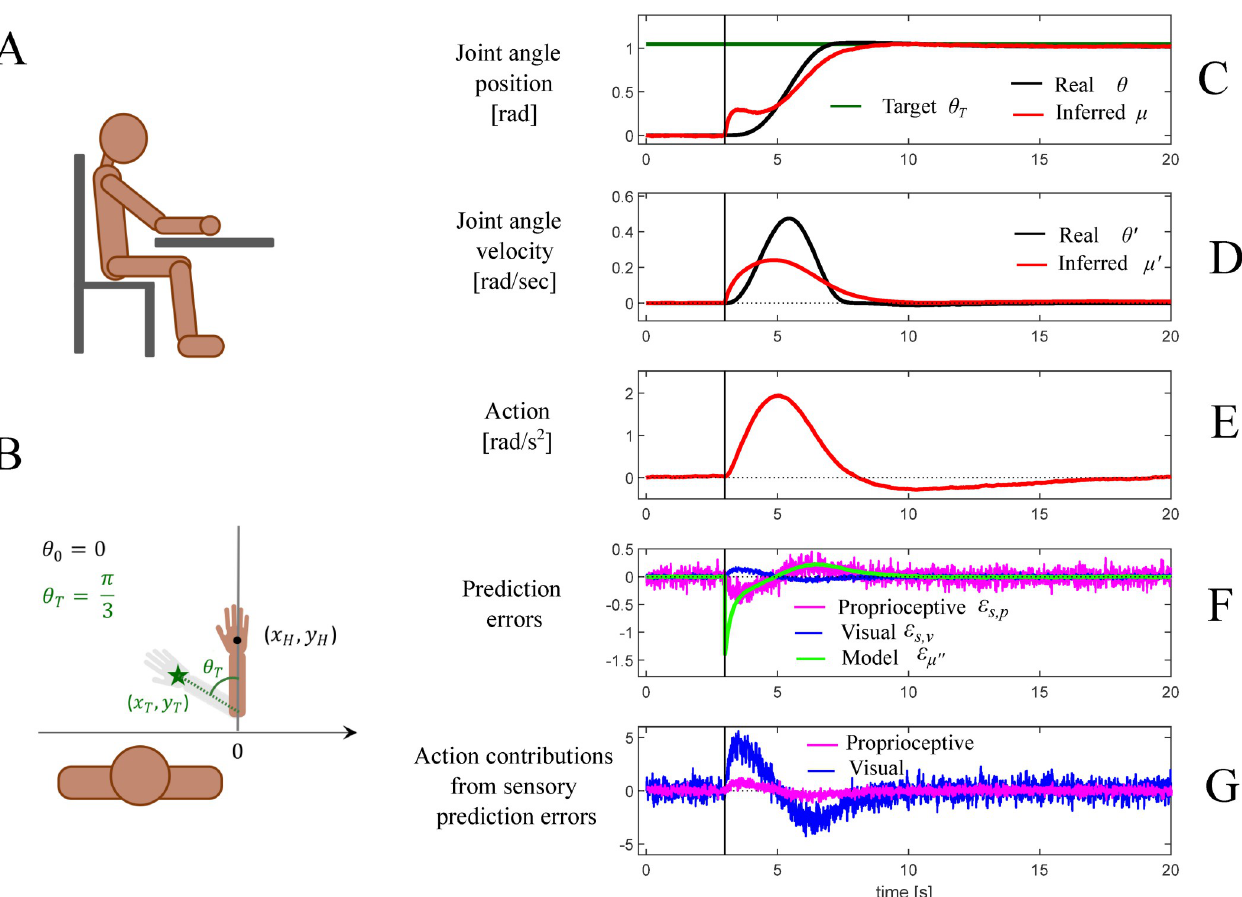
Fig 7. First simulation: reaching a fixed target in space. (A) Schematic representation of the agent having direct vision of his own arm, which initially rests on a table surface and could only move by rotating the elbow around the vertical axis. (B) Task specification. The agent has to reach a target location (green star) by rotating the arm so to reach the configuration shown in grey, at θ , corresponding to having the hand at the target location [ x ] = g(θ . (C-G) T T , y T T ) Dynamics of the model variables during the task. The vertical bars mark the time at which the target location is disclosed. (C) Joint angle of the real (black) and inferred (red) arm configurations, expressed in radians; the green line represents the arm configuration θ for which the hand is on the target. (D) Real T (black) and inferred (red) velocity of the elbow joint angle velocity. (E) Action, represented in our model as an angular acceleration. (F) The three prediction errors considered in the model: model dynamics error (green) and the two sensory errors, proprioceptive (magenta) and visual (blue). Please note that in this plot, the prediction error units correspond to different dimensions and cannot be directly compared. (G) Contributions of proprioceptive (magenta) and visual (blue) errors in determining the action, more specifically the two vector components in the r.h.s. of Eq G4 in Fig 6. See the main text for